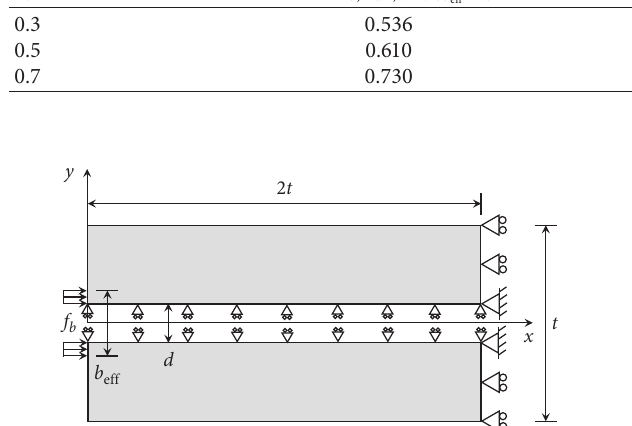
Figure 7: Structural analysis model for anchorage zone with a duct hole (plan view).